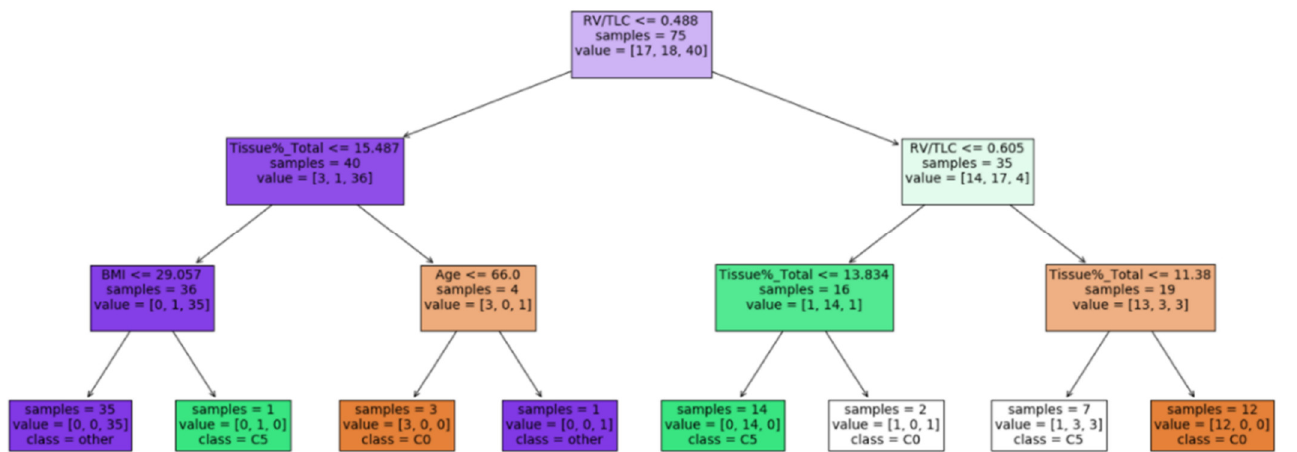
Figure 11. A decision tree model which takes the imaging-based variables and the clinical variables as inputs and predicts the cluster membership.